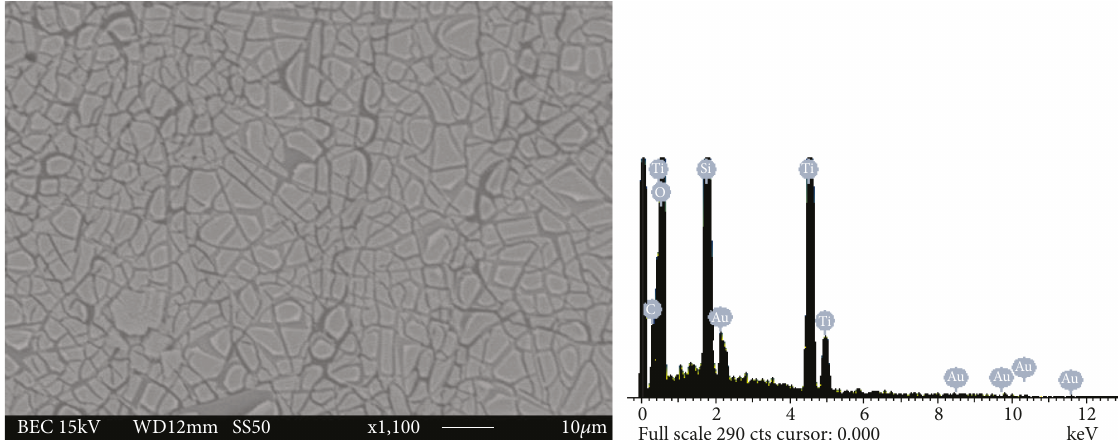
fi lm after 4 treatment cycles and 1 hour of immersion under mechanical stirring. 2 on the SiO 2 2